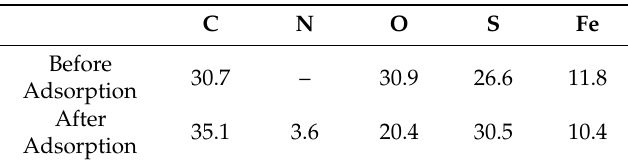
Table 6. Atomic concentrations (%) of elements on the surface of pyrite (1 0 0) before and after adsorption of cysteine.